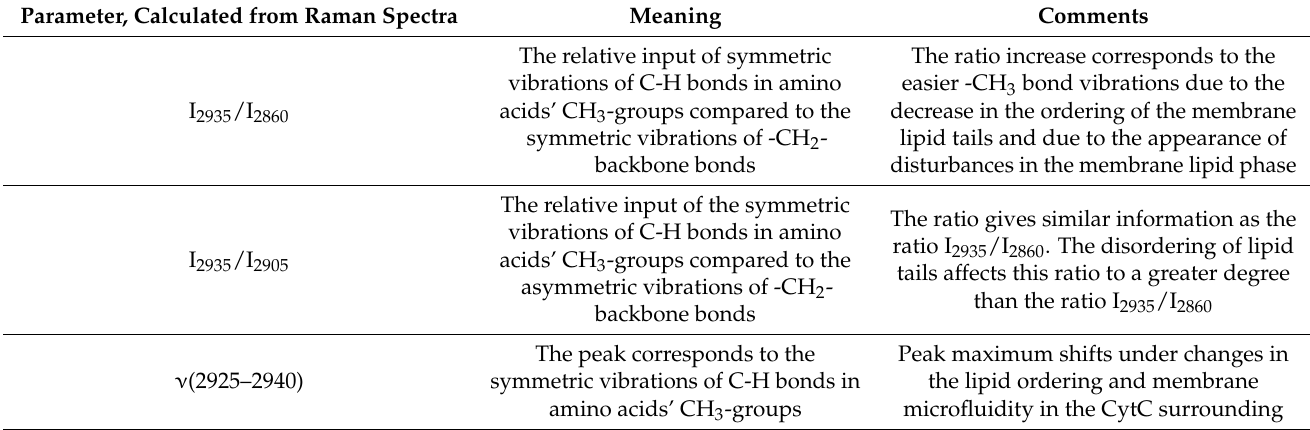
Table 2. Peak ratios used for the analysis of CytC interaction with the CL of